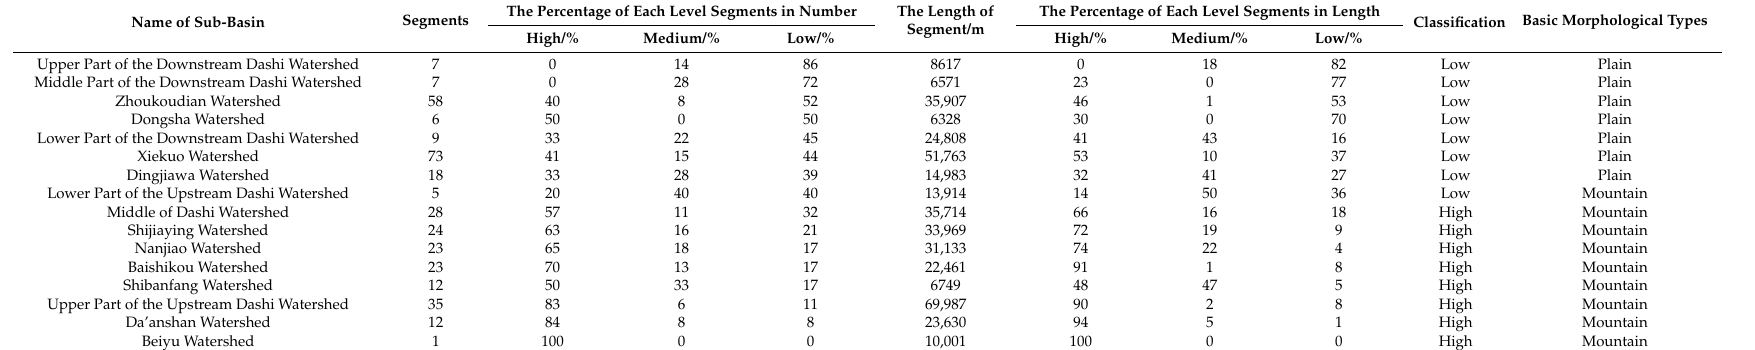
Table 4. Percentage of river segments with different levels of connectivity in each